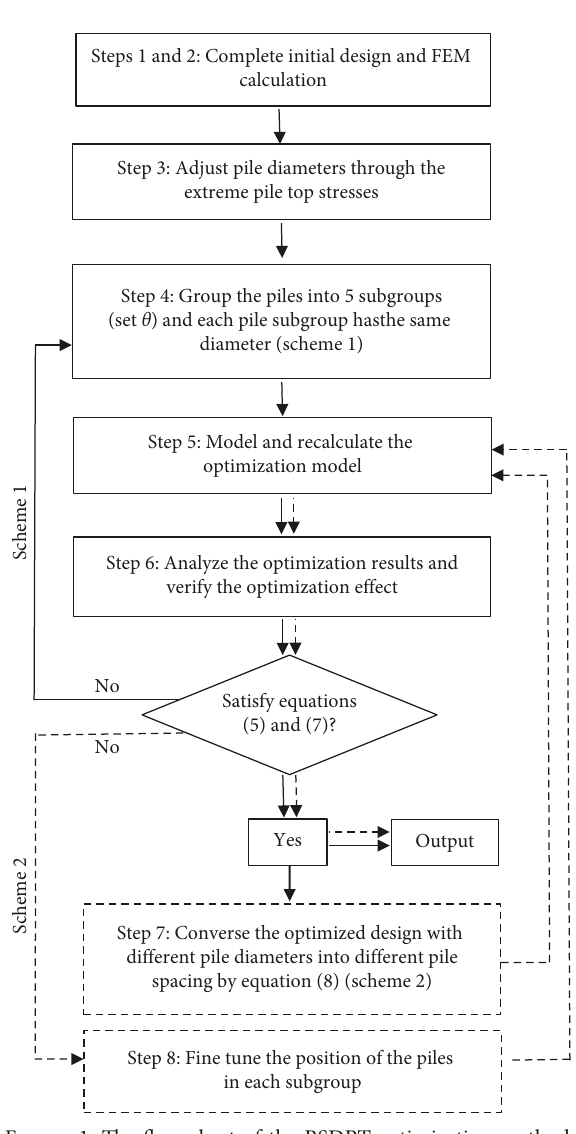
Figure 1: The flow chart of the BSDPT optimization method.